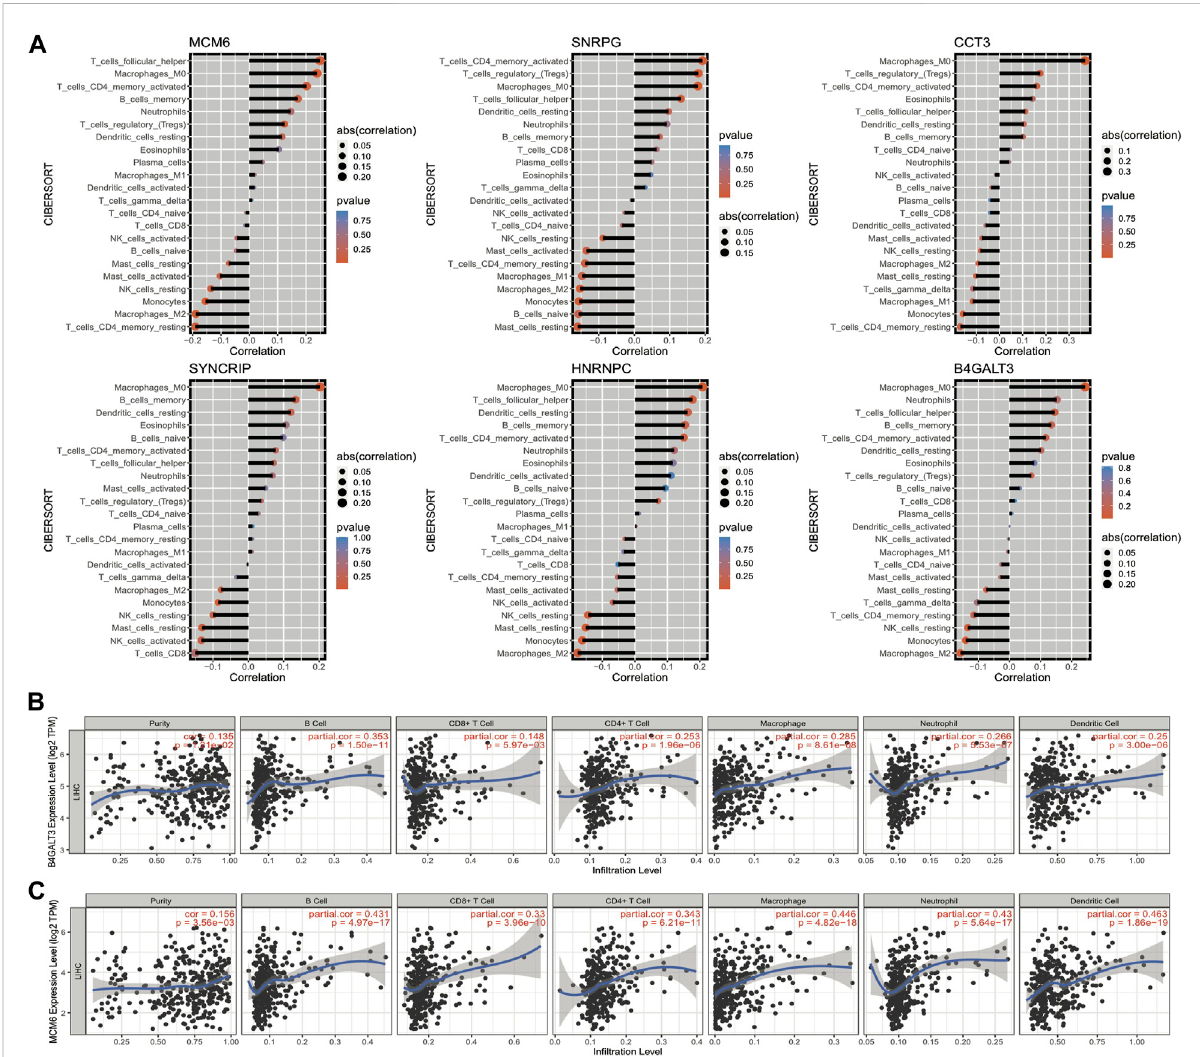
FIGURE 11 Correlation between the expression of model genes and the proportion of immune cell in fi ltration. (A) Bar graph of the correlation between model gene expression and the proportion of immune cell in fi ltration, the length of the bars demonstrate the size of the correlation, and the color represents the signi fi cant p -value of the correlation; (B,C) Scatter plots of correlation coef fi cients between the expression values of model genes B4GALT3 and MCM6 (TPM) and the proportion of immune cell in fi ltration obtained from TIMER online website